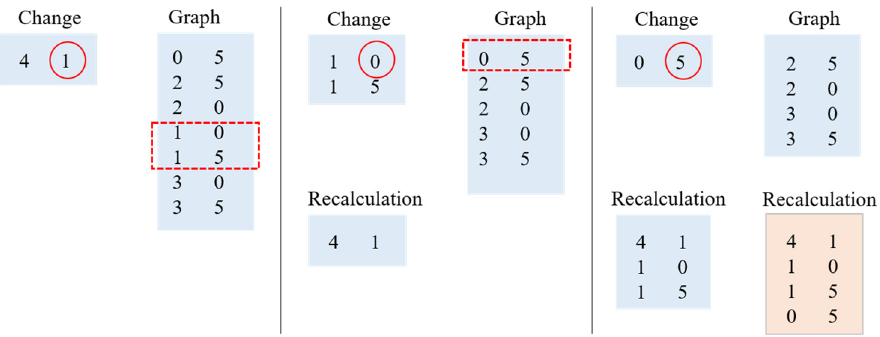
Figure 3. Processing ratio detection in